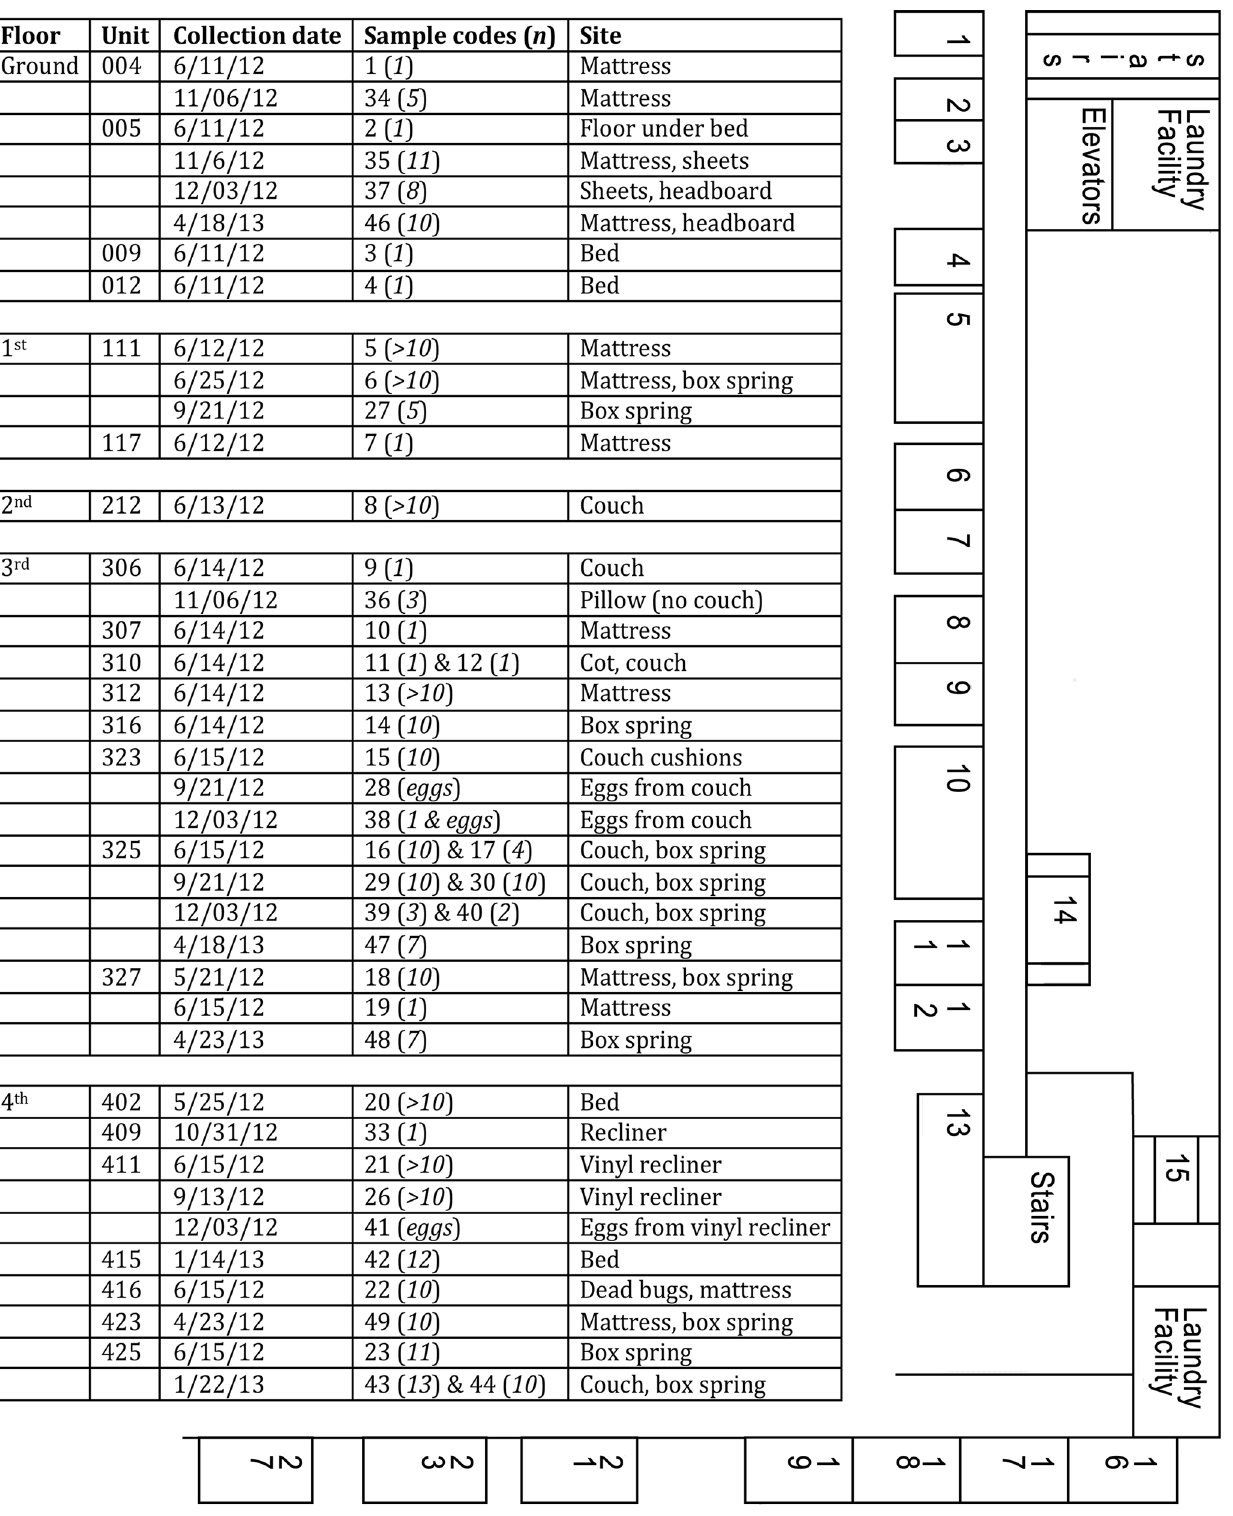
Fig 1. Units and dates in an apartment complex from which bed bugs were collected from May 2012 to April 2013. Consecutive sample numbers 11 & 12, 16 & 17, 29 & 30, 39 & 40, and 43 & 44 represent two sites in the same apartment from which bed bugs were collected on the same date. The number of bed bugs in each sample ( n ) is provided after the sample number. Sample 24 was an internal laboratory colony and is not shown. Samples 31 and 32